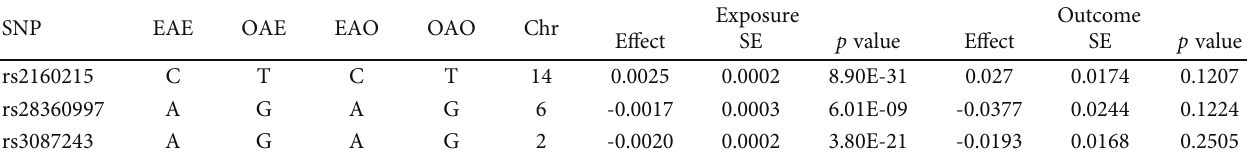
Table 4: Univariate Mendelian randomization analysis for the e ff ects of hyperthyroidism on venous thromboembolism risk. SNP